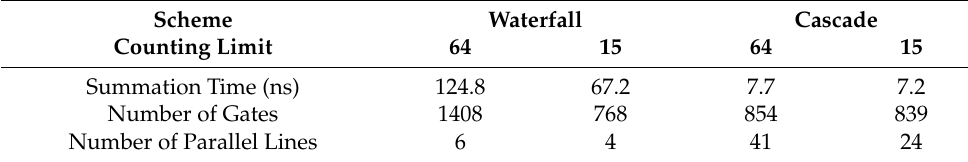
Table 2. Resources required for cascade and waterfall summation schemes. Scheme Waterfall Cascade Counting Limit